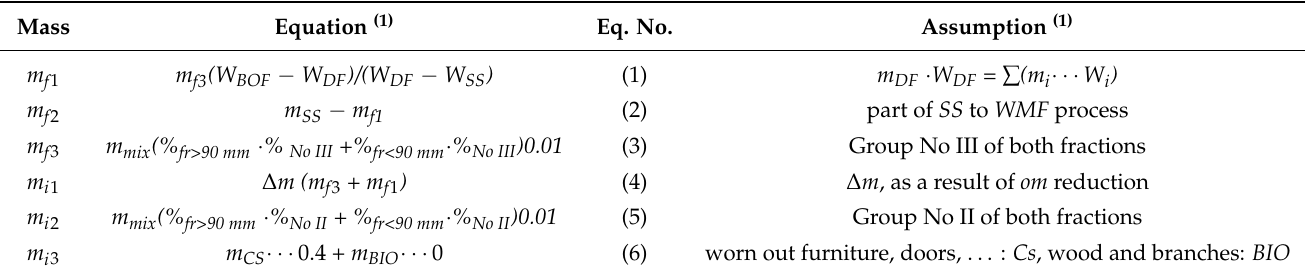
Table 3. Mass balance equations.